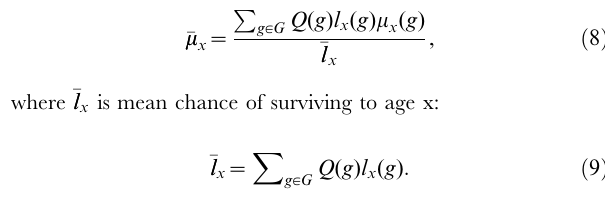
Frequency of mutations at L1 and L2: